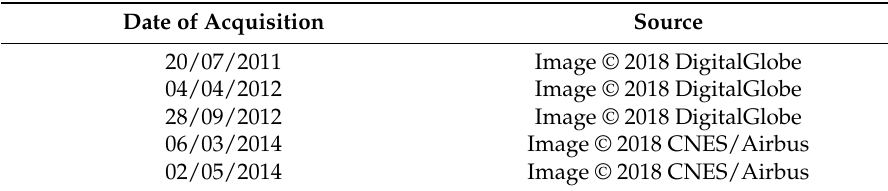
Table A2. VHR optical satellite data accessed through Google Earth covering the UNESCO TWHS of Apamea (Syria) and referred to in Section 3.2.